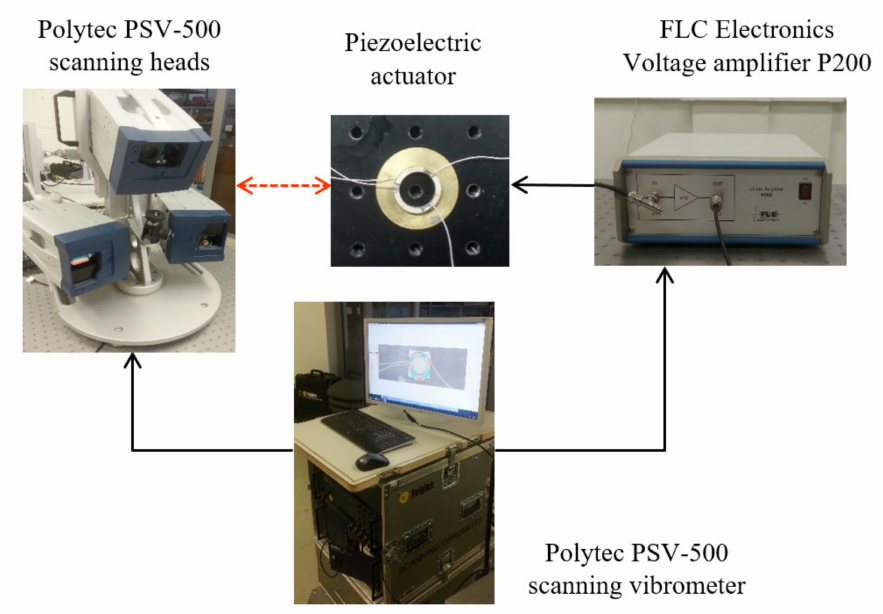
Figure 11. Measurement instruments used in experiments: Polytec Laser Doppler Scanner